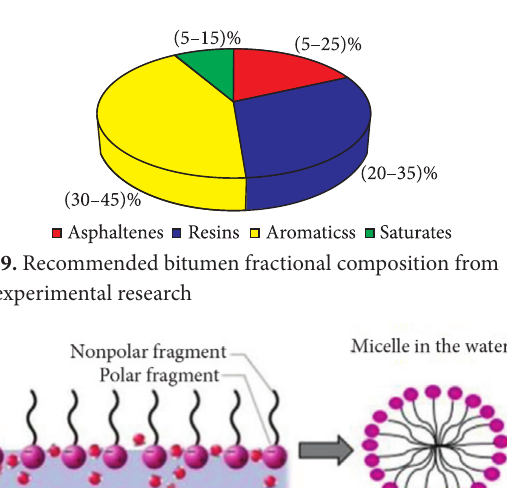
fig. 8. The change in the fractional composition of bitumen 50/70 produced by different producers before and after short-term aging